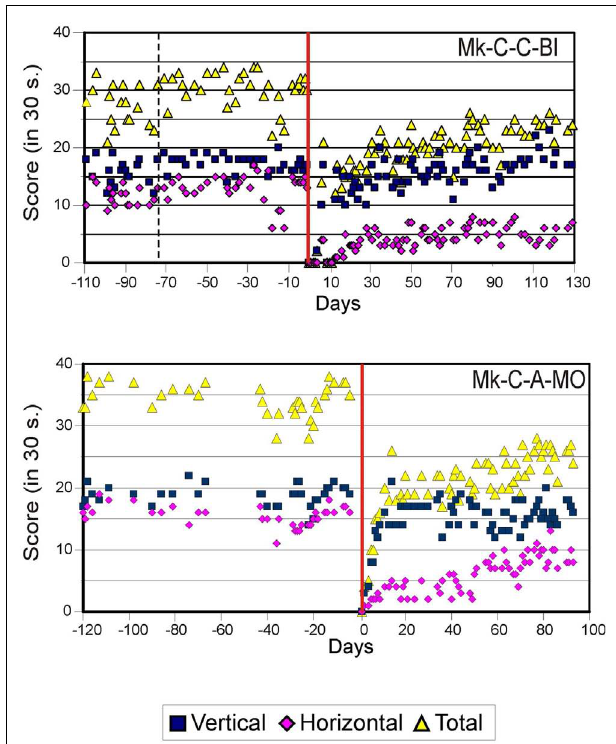
FIGURE 3 | Graphic representation of the number of pellets retrieved in 30s pre- and post-lesion during multiple daily sessions for two representative monkeys subjected to motor cortex lesion (Mk-C-C-BI and Mk-C-A-MO) . Same conventions as in Figure 2 . Modified from Kaeser et al. (12, 13) and Bashir et al.